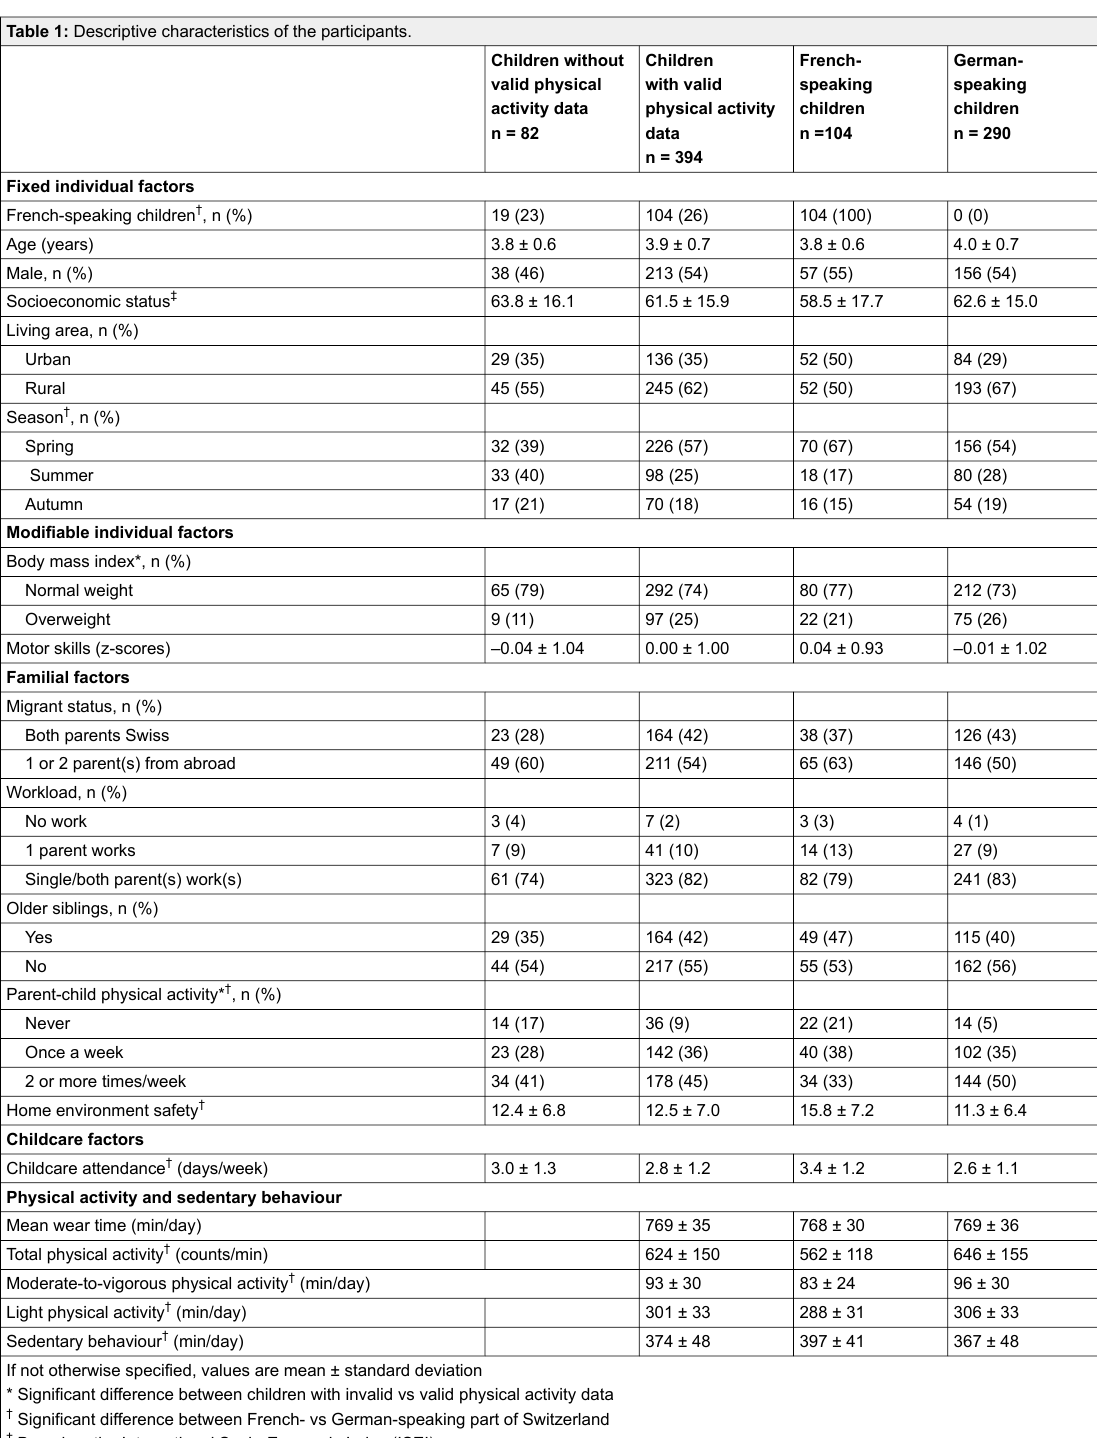
Table 1: Descriptive characteristics of the